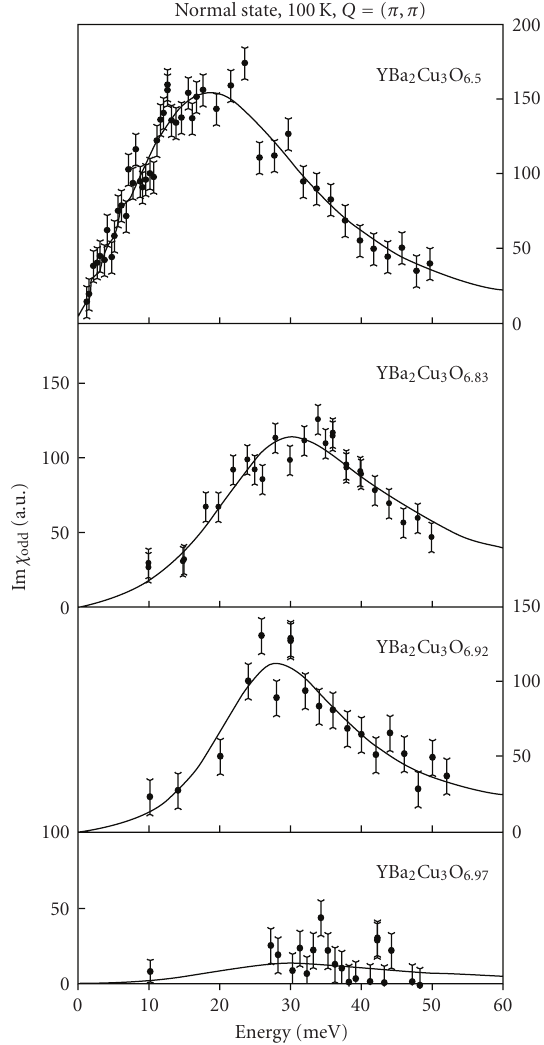
Figure 2: Magnetic spectral function Im χ ( − ) ( k , ω ) in the normal state of YBa 2 Cu 3 O 6+ x at T = 100K and at Q = ( π , π ). 100 counts in the vertical scale correspond to χ ( − ) superconducting critical temperature T c ( x ) by increasing doping ( x ) from the underdoped system with x = 0 . 5 (top) to the optimally doped one with x = 0 . 97 (bottom): T c ( x ) = 45K ( x = 0 . 5), 85K ( x = 0 . 83), 91K ( x = 0 . 92), and 92 . 5K ( x = 0 . 97). From